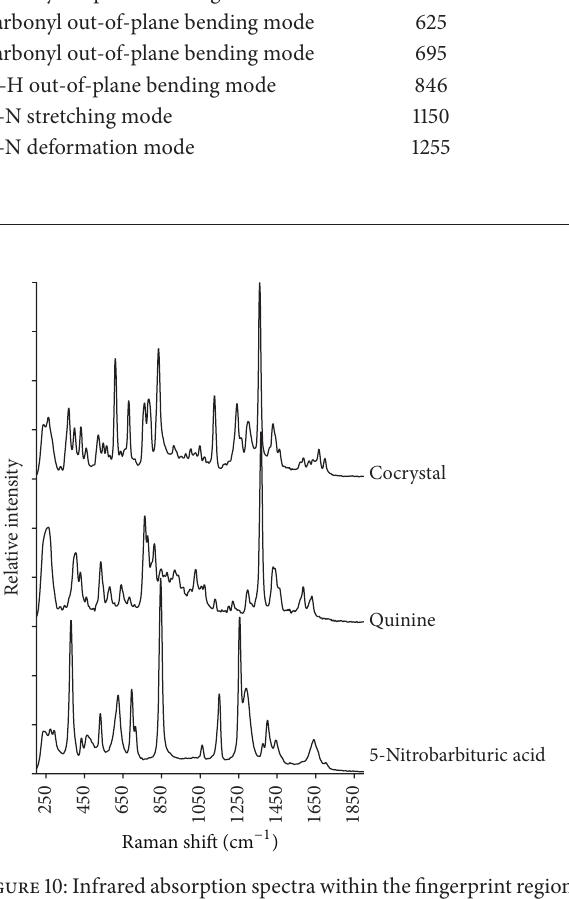
Figure 10: Infrared absorption spectra within the fingerprint region of 5-nitrobarbituric acid, quinine, and the 1 :1 nitrobarbituric- quinine cocrystal.